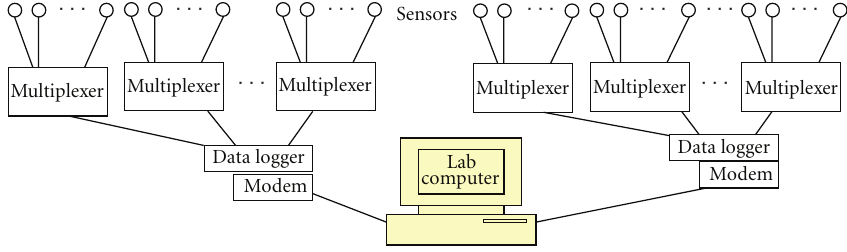
jointN Cast-in- p lace gr out Figure 1: Parkview Bridge deck layout.